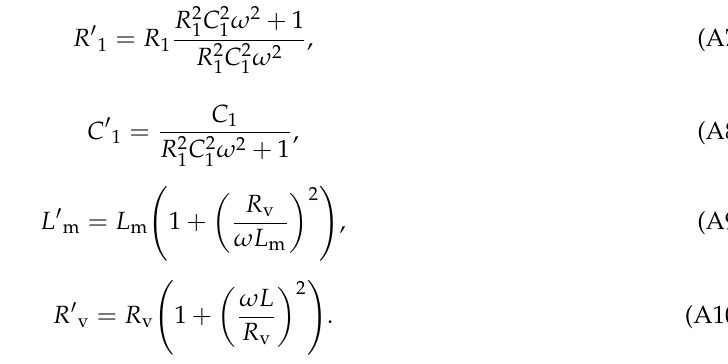
= 824 k Ω , C (cid:48) = 49 fF, R (cid:48) = 12.8 k Ω , L (cid:48) = 27 v m 1 1